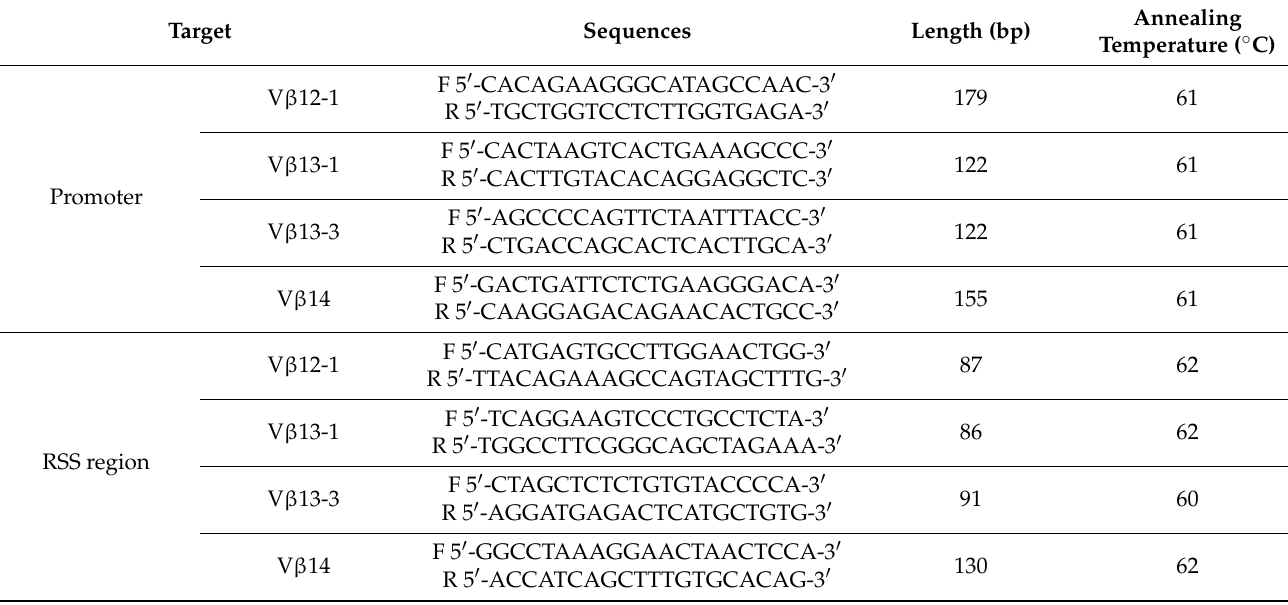
Table 5. Primers used for ChIP